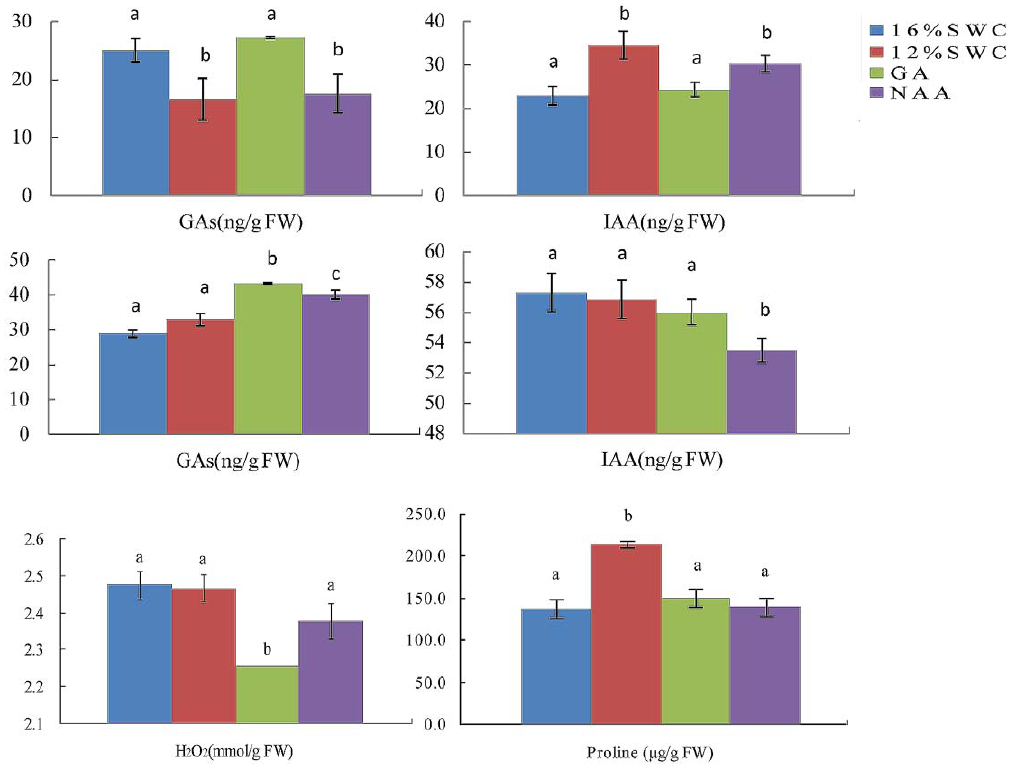
Figure 4. Effects of plant growth regulators on levels of endogenous GAs and IAA in roots (A, B) and leaves (C, D), and on the content of H 2 O 2 (E) and proline (F) in roots of S. baicalensis . Vertical lines indicate the standard deviation of three biological replicates. Asterisks indicate a significant difference at the P , 0.05 level.